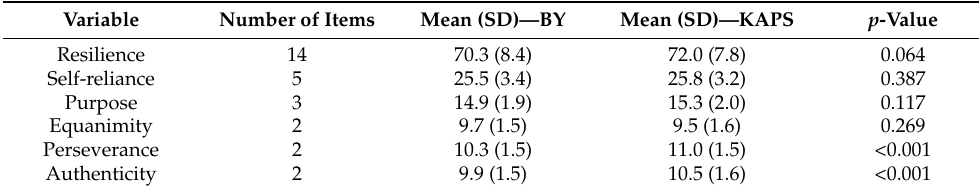
Table 2. Summary of resilience and its dimension scores for cattle farmers in the Bunkpurugu-Yunyoo (BY) and Kwahu Afram Plains South (KAPS) districts.